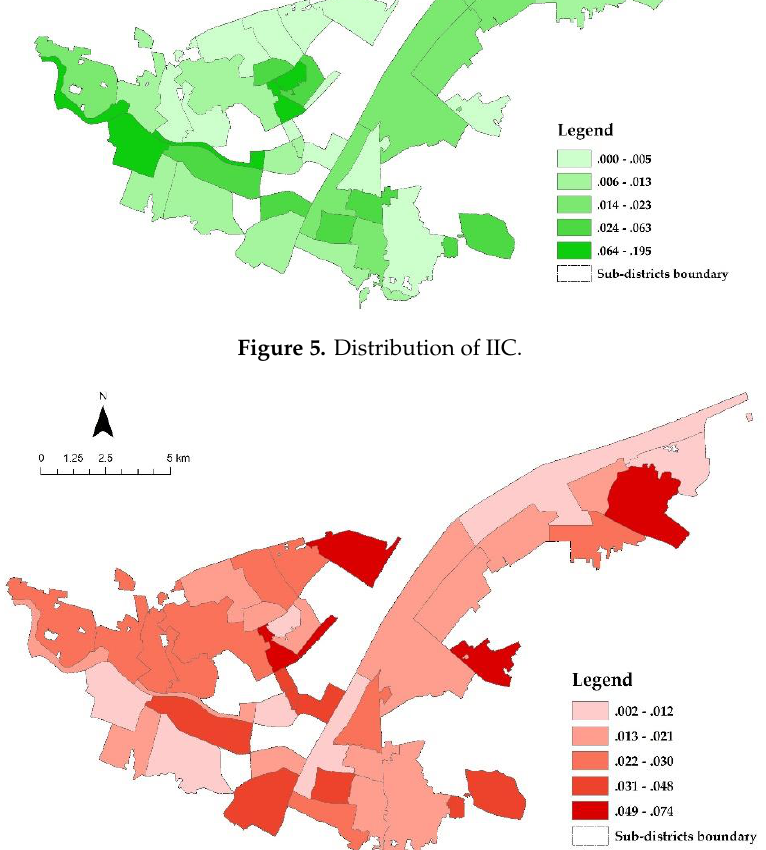
Figure 6. Distribution of PGS use.